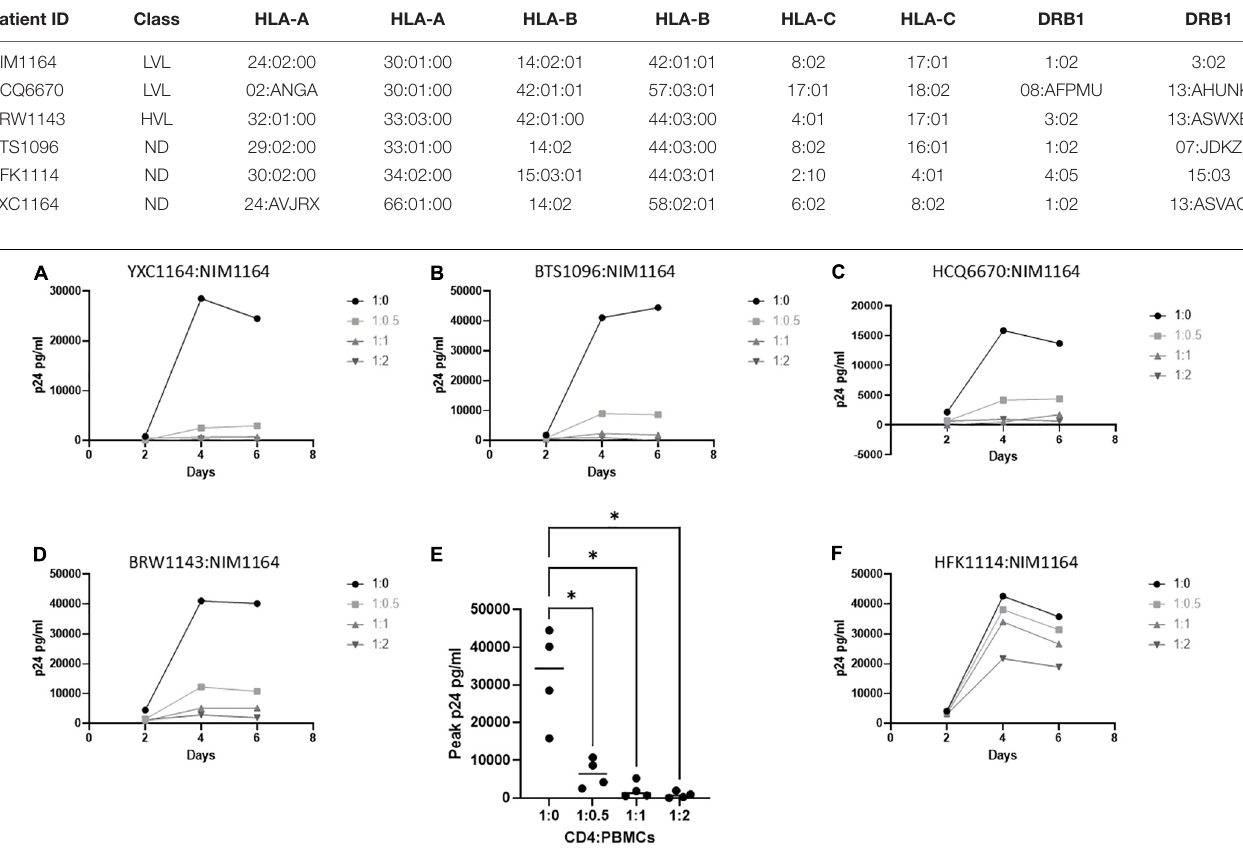
FIGURE 4 | HLA compatibility is a requirement for LVL mediated HIV-1 suppression in heterologous CD4 + T-cells. PBMCs from LVL NIM1164 and isolated CD4 + T-cells from donors with varying degrees of HLA match were induced with PHA and IL-2. Heterologous CD4 + T-cell isolates from HLA-matched